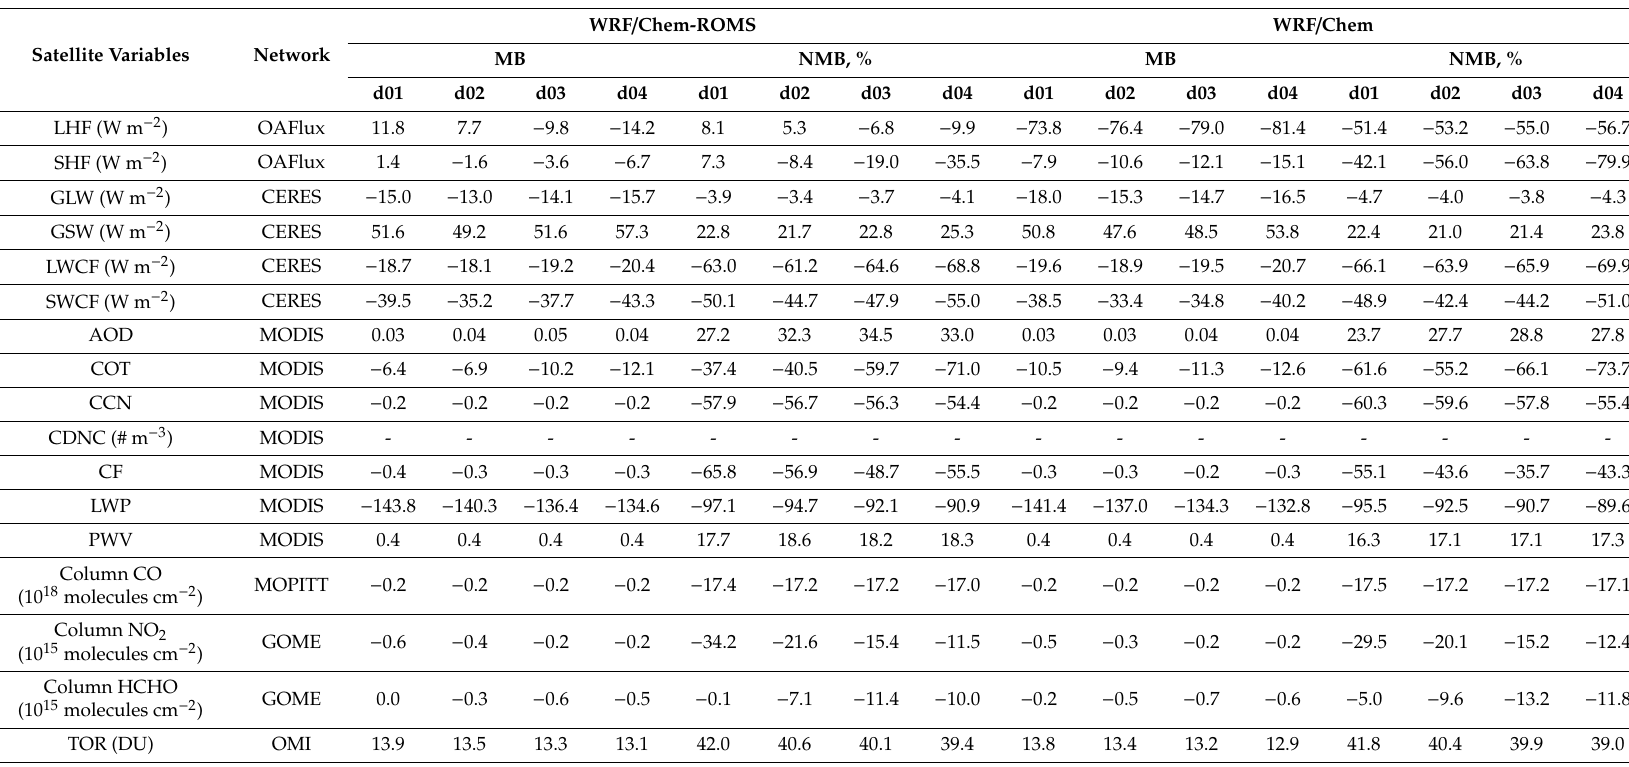
Table 6. Mean bias (MB) and normalized mean bias (NMB) (%) of column variables from WRF / Chem and WRF / Chem-ROMS simulations at 81 km (d01), 27 km (d02), 9 km (d03), and 3 km (d04) over the 3 km domain for the MUMBA field